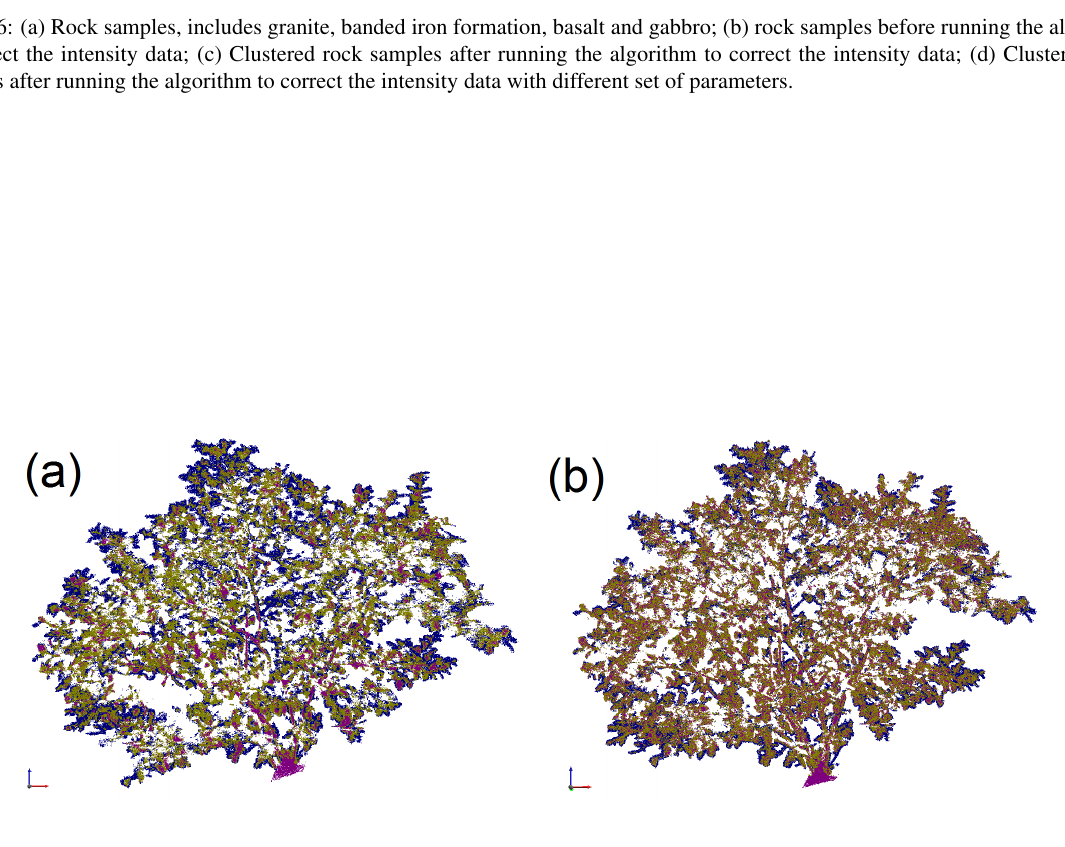
Figure 7: Clustered tree before (a) and after (b) the return intensity recovery algorithm to be